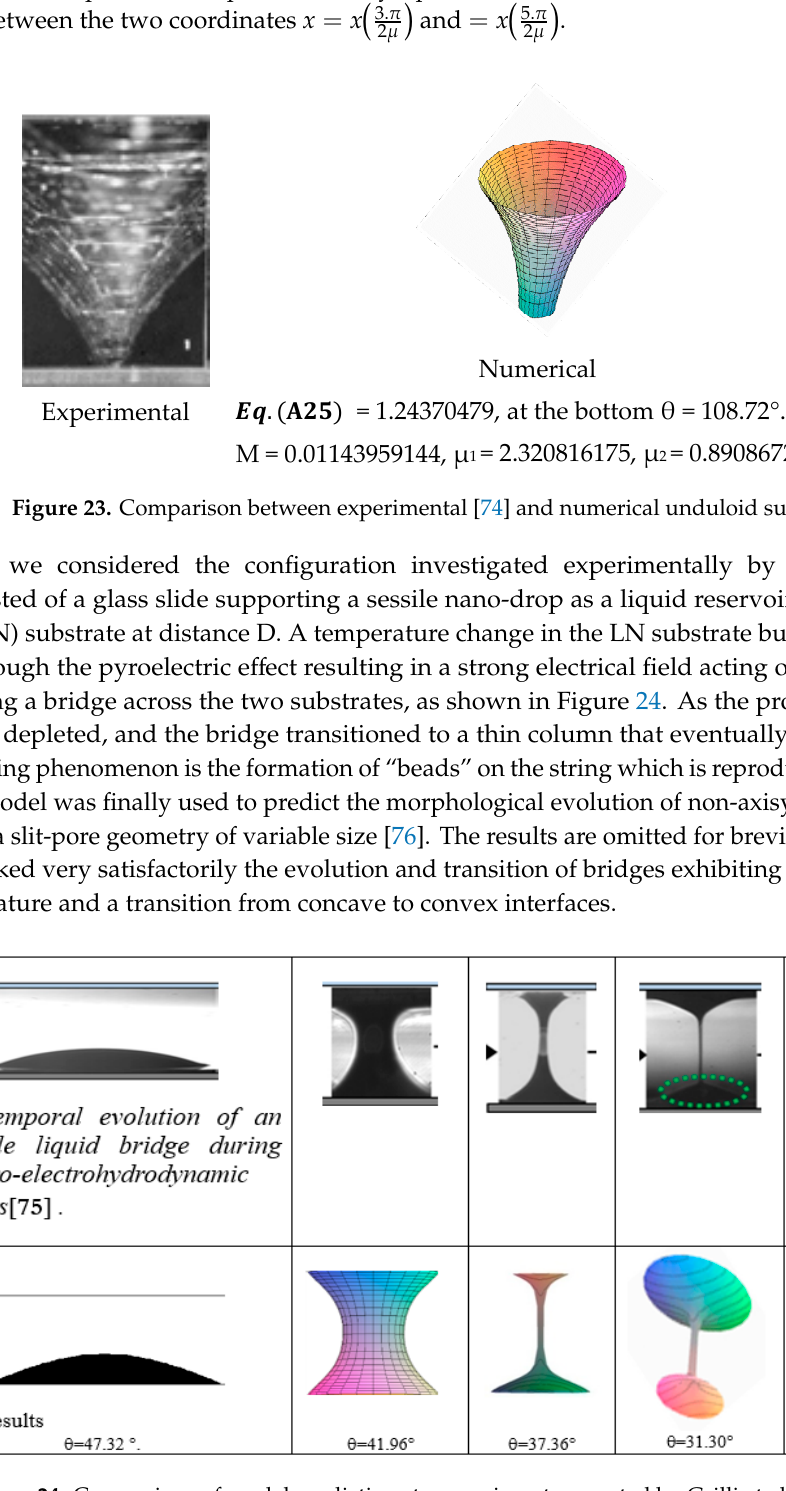
Figure 24. Comparison of model predictions to experiments reported by Grilli et al., 2011 [ 75 ] .